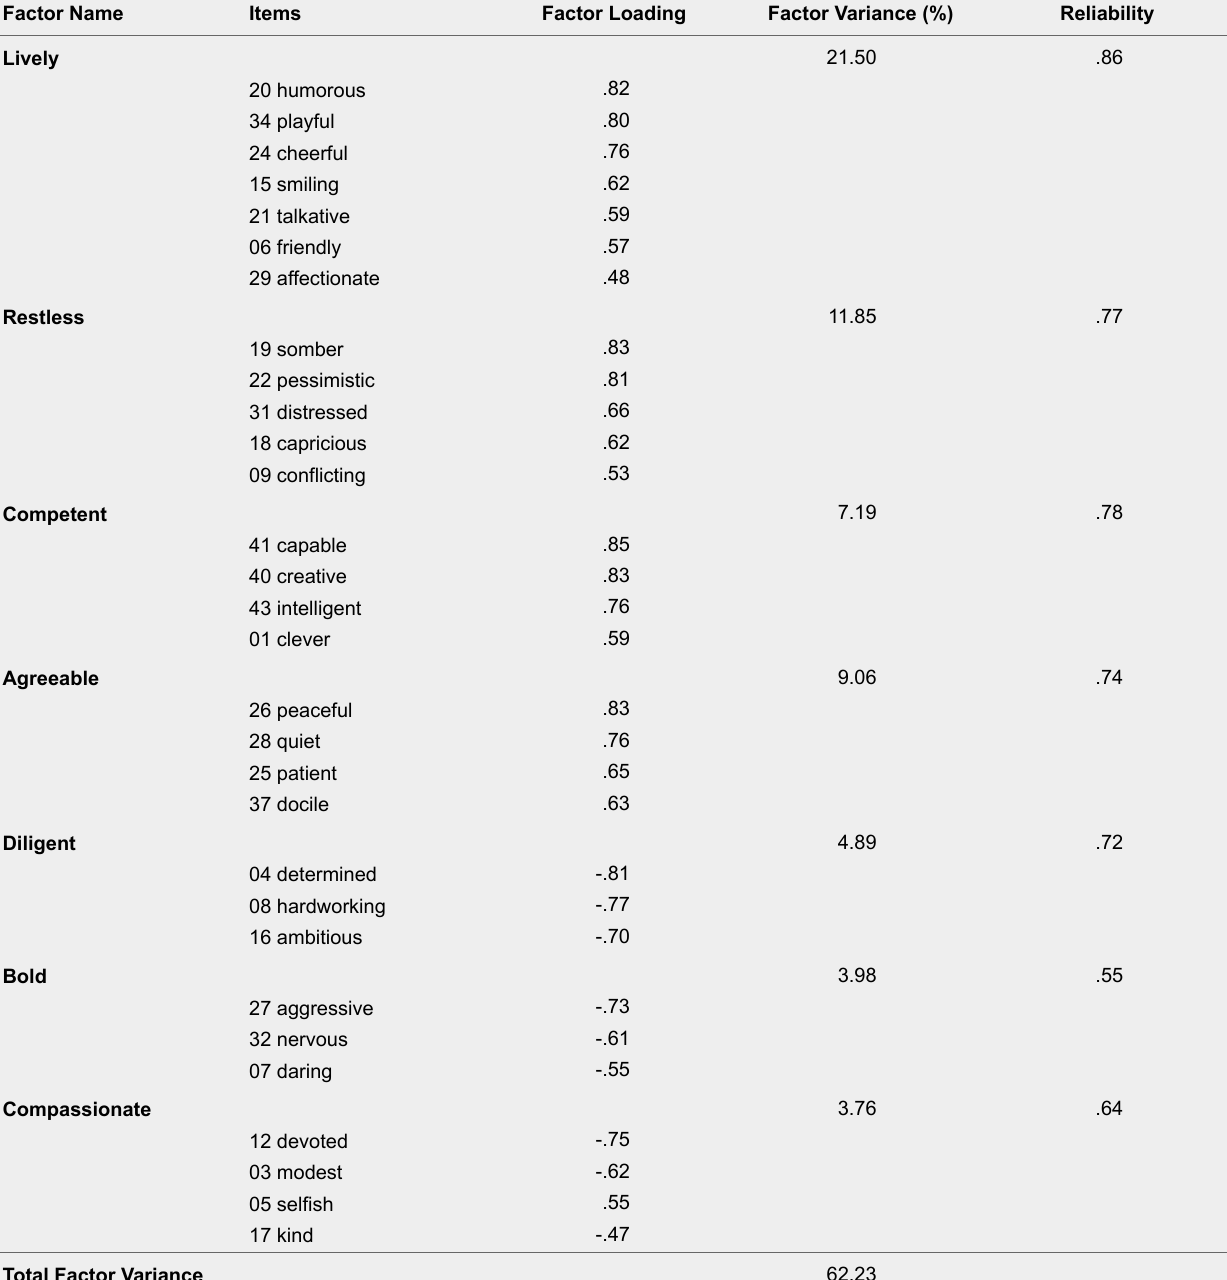
Factor Structure for Personality Profile